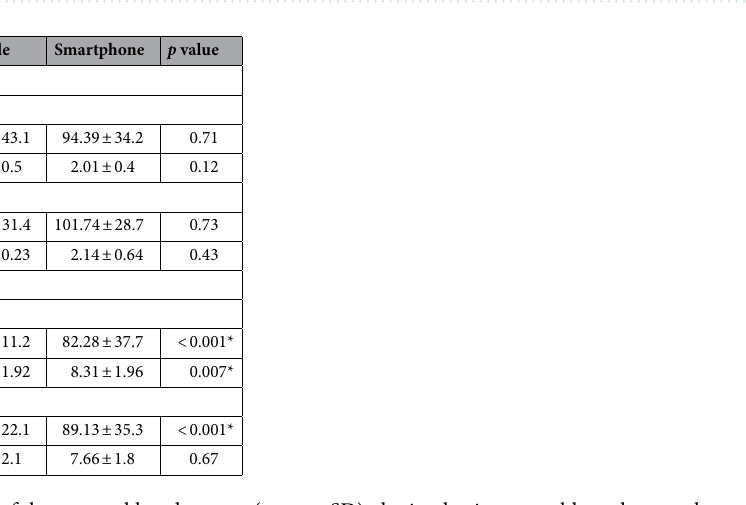
Figure 3. Power spectrum of the tremor in postural condition recorded by the smartphone in the dominant hand ( a ), lightweight portable in the dominant hand ( b ), and comparison between both devices in the dominant hand ( c ). ( d ), ( e ) and ( f ) represent similar plots for non-dominant hand recordings.